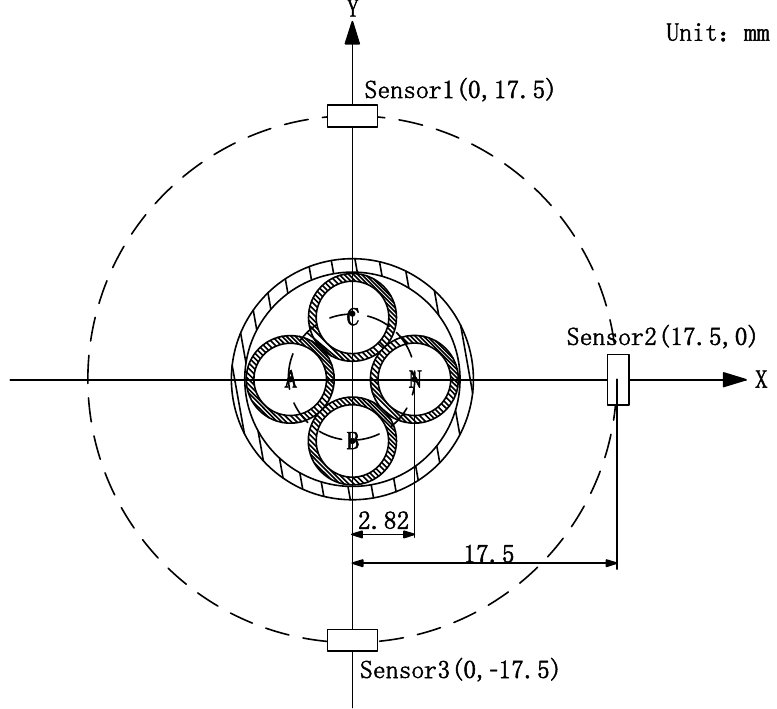
Figure 5. Sensor array design and physical drawing.